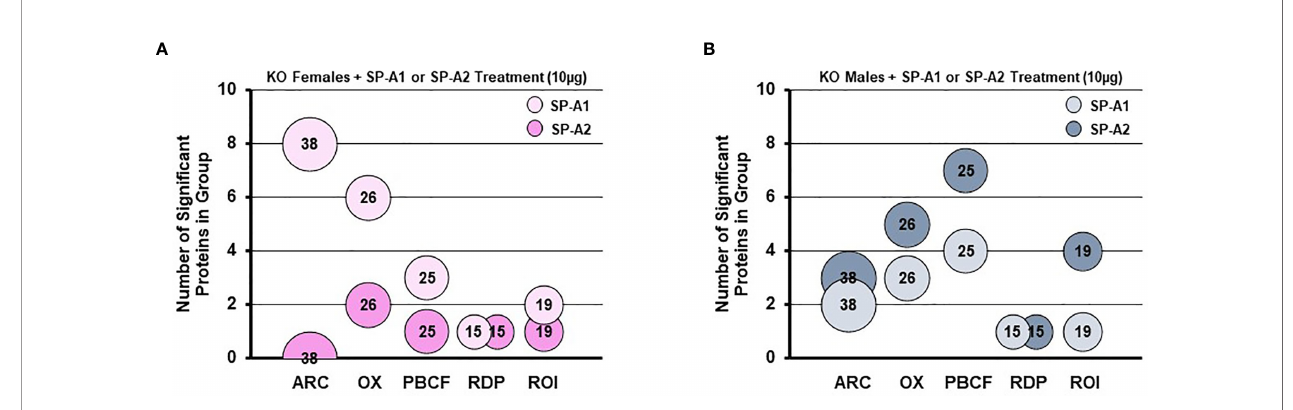
FIGURE 8 | Sex differences of the AM proteome in response to in vivo rescue of SP-A KO mice with different human SP-A variants. (A, B) show differential effects of SP-A1 and SP-A2 in females (A) and males (B) in terms of various functional protein groups. Bubble size and number depict the number of proteins within each group (114). ARC, actin-related cytoskeletal; OX, oxidative stress; PBCF, protease balance/chaperone function; RDP, regulatory/developmental processes; ROI, regulation of in